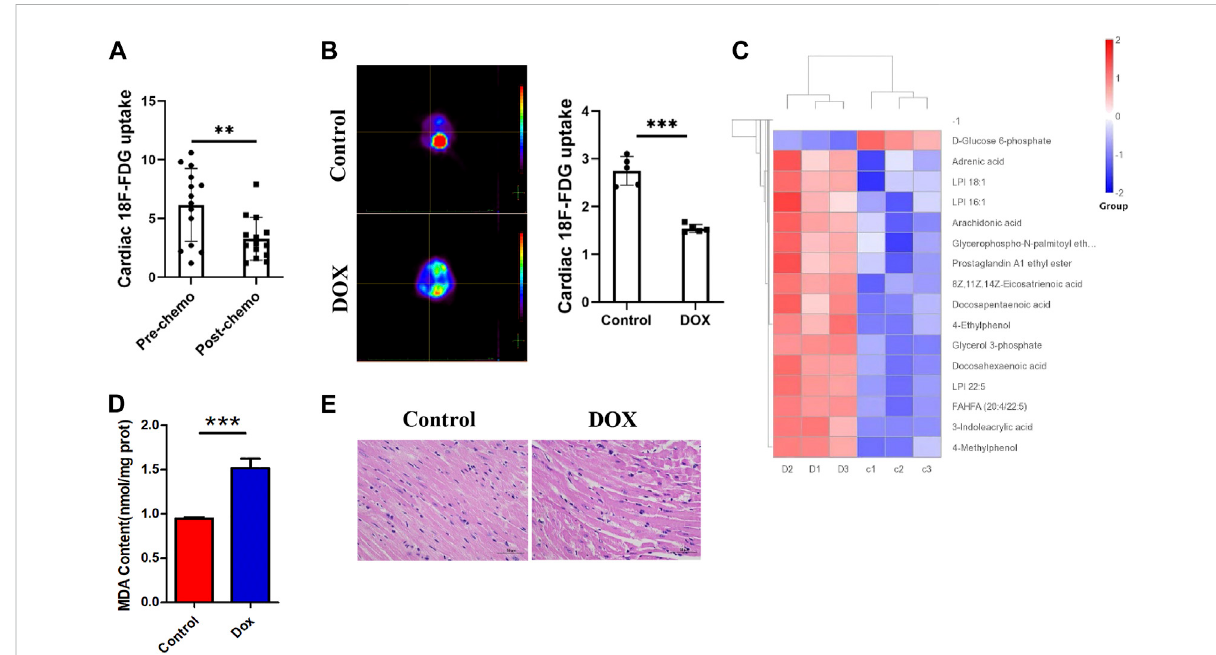
FIGURE 1 (A) Concentration of 18 F-FDG taken up by the hearts of patients treated with chemotherapy and without chemotherapy. (B) 18 F-FDG PET/CT image acquisition and cardiac 18 F-FDG uptake. (C) Heat map of Dox-treated mice. (D) MDA content in H9c2 cells. (E) HE staining showing that Dox reduced the cardiomyocyte size. Control vs. Dox: *** p < 0.0005, ** p < 0.005, * p < 0.05, mean ± SD. n = 6 –